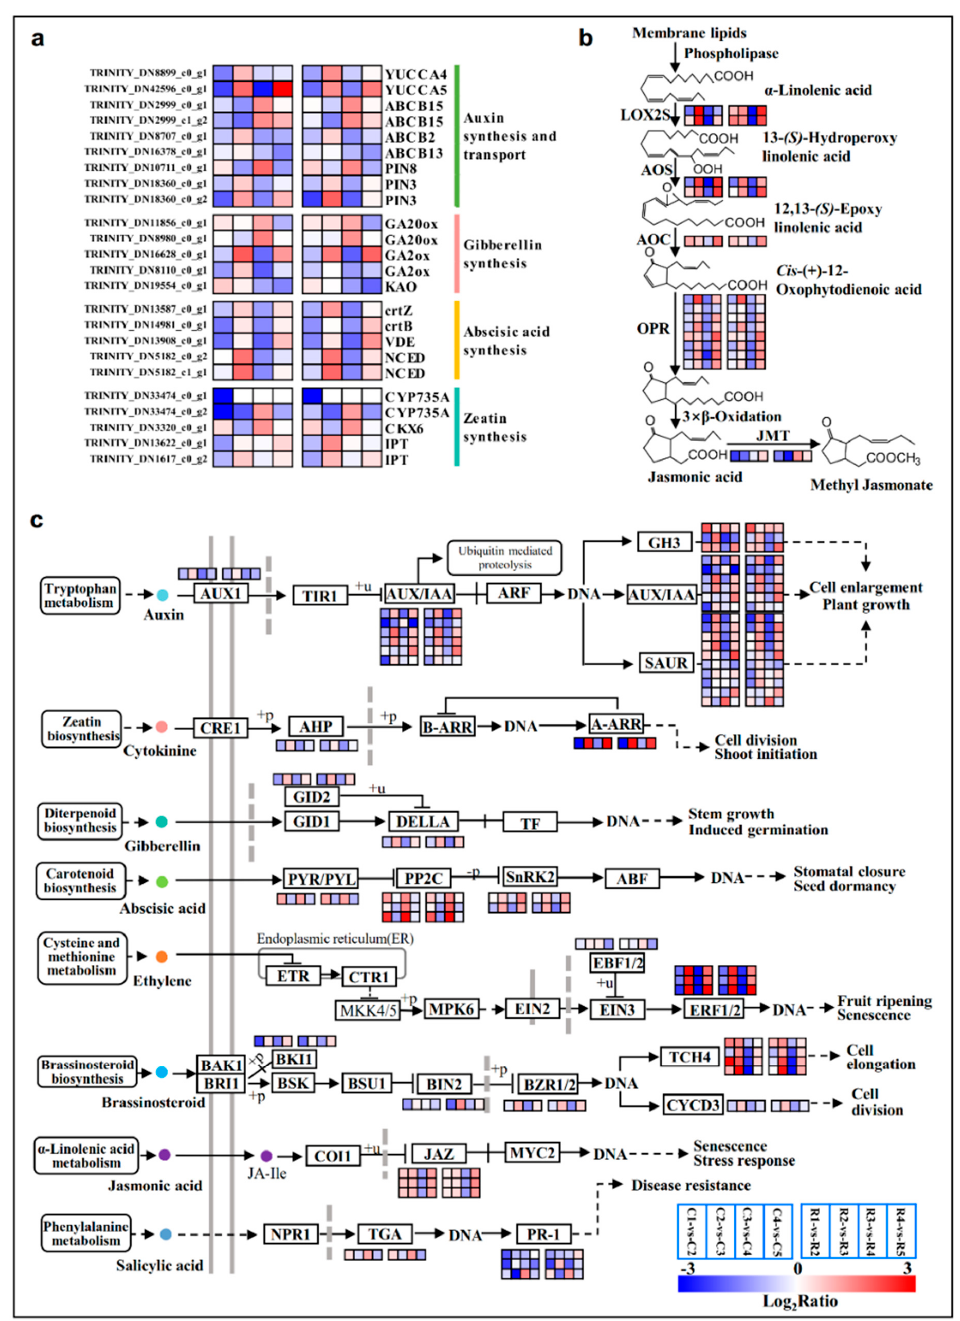
Figure 6. Significant expressed genes involved in IAA, ABA, GAs, Zeatin ( a ), and JA ( b ) biosynthesis during the differentiation phases, and the signal transduction pathways of these plant hormones ( c ). Color codes from blue to red indicate changes in transcriptional expression levels between − 3 and 3. The boxes from left to right indicate the expression values of a unigene obtained in C1 vs C2, C2 vs C3, C3 vs C4, C4 vs C5; R1 vs R2, R2 vs R3, R3 vs R4, R4 vs R5, respectively. Each row represents a separate unigene.